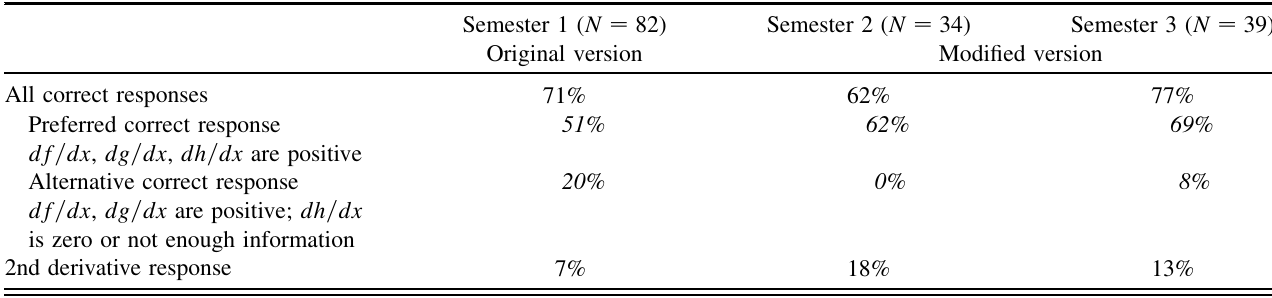
TABLE II. Response distribution for Derivative Sign and Ranking Task. Percentage in the ‘‘All correct responses’’ row are the sum of the ‘‘Preferred’’ and ‘‘Alternative correct responses’’; 2nd derivative responses are those students whose sign choice is consistent with that of the 2nd derivative, but not necessarily identified by the student as a 2nd derivative